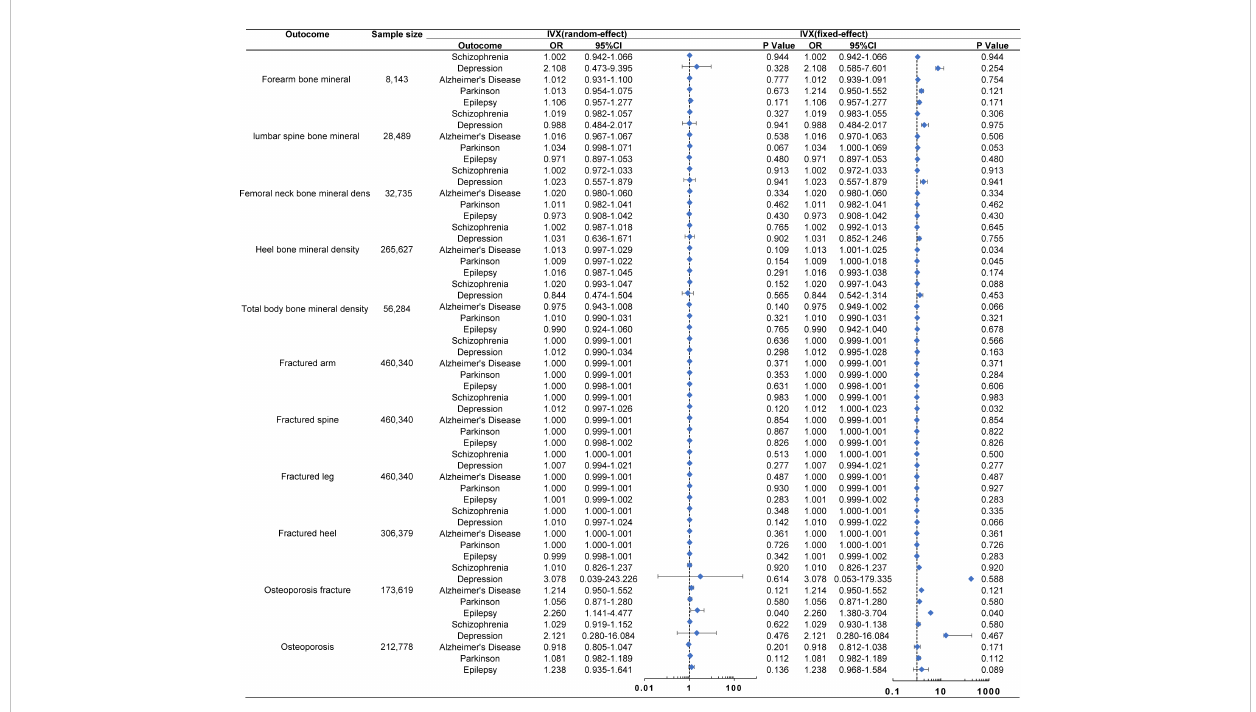
FIGURE 2 Associations of genetically predicted MDs with the risk of OP. The Forest plot of causal relationship between MDs and the risk of OP using the IVX. All p -values > 0.05 in the IVW random method. OR, odds ratio; IVX, inverse variance weighting; CI, con fi dence